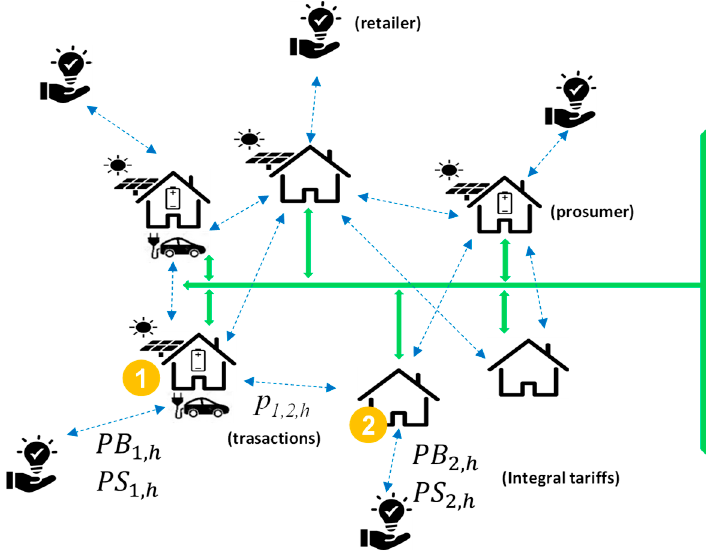
Figure 1. Overview of electricity exchanges in a local electricity market.